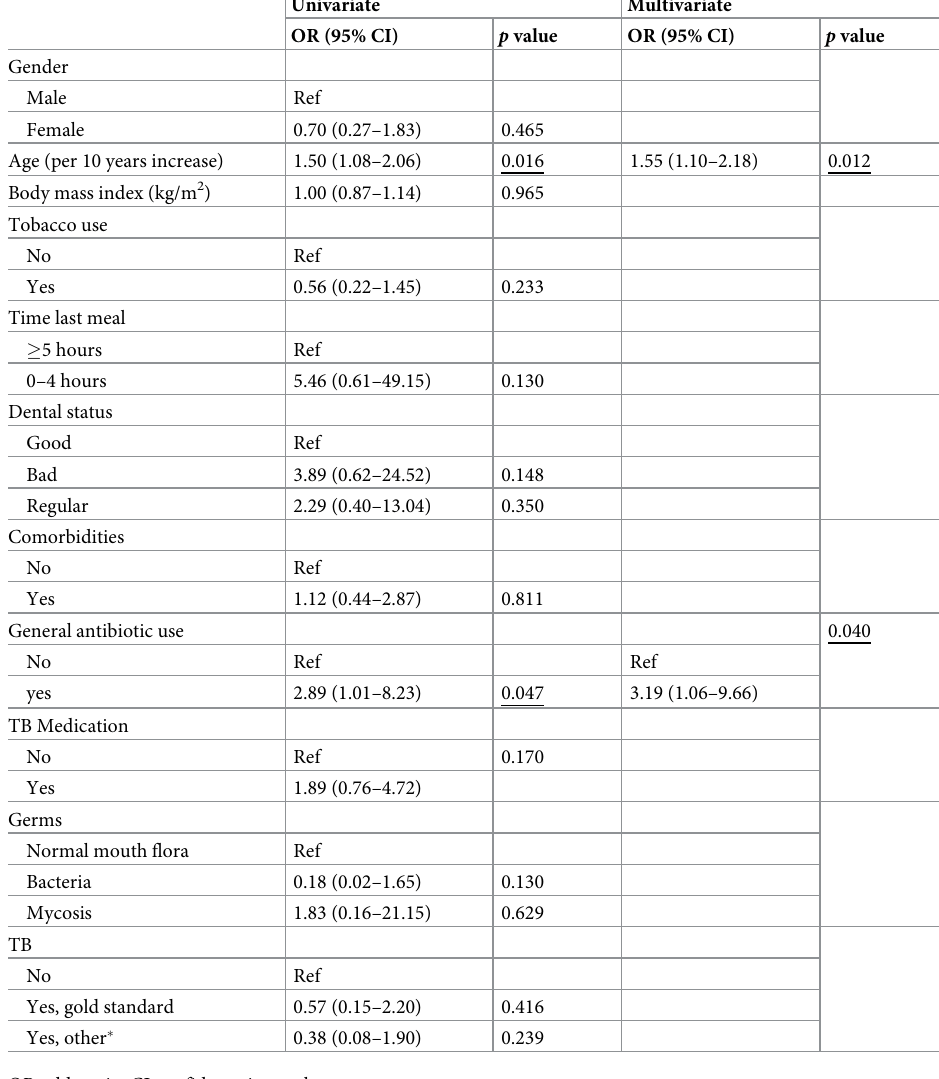
Table 4. Univariate and multivariate logistic regression analysis for incorrect classifications in the neural network algorithm (blind prediction data set (n =